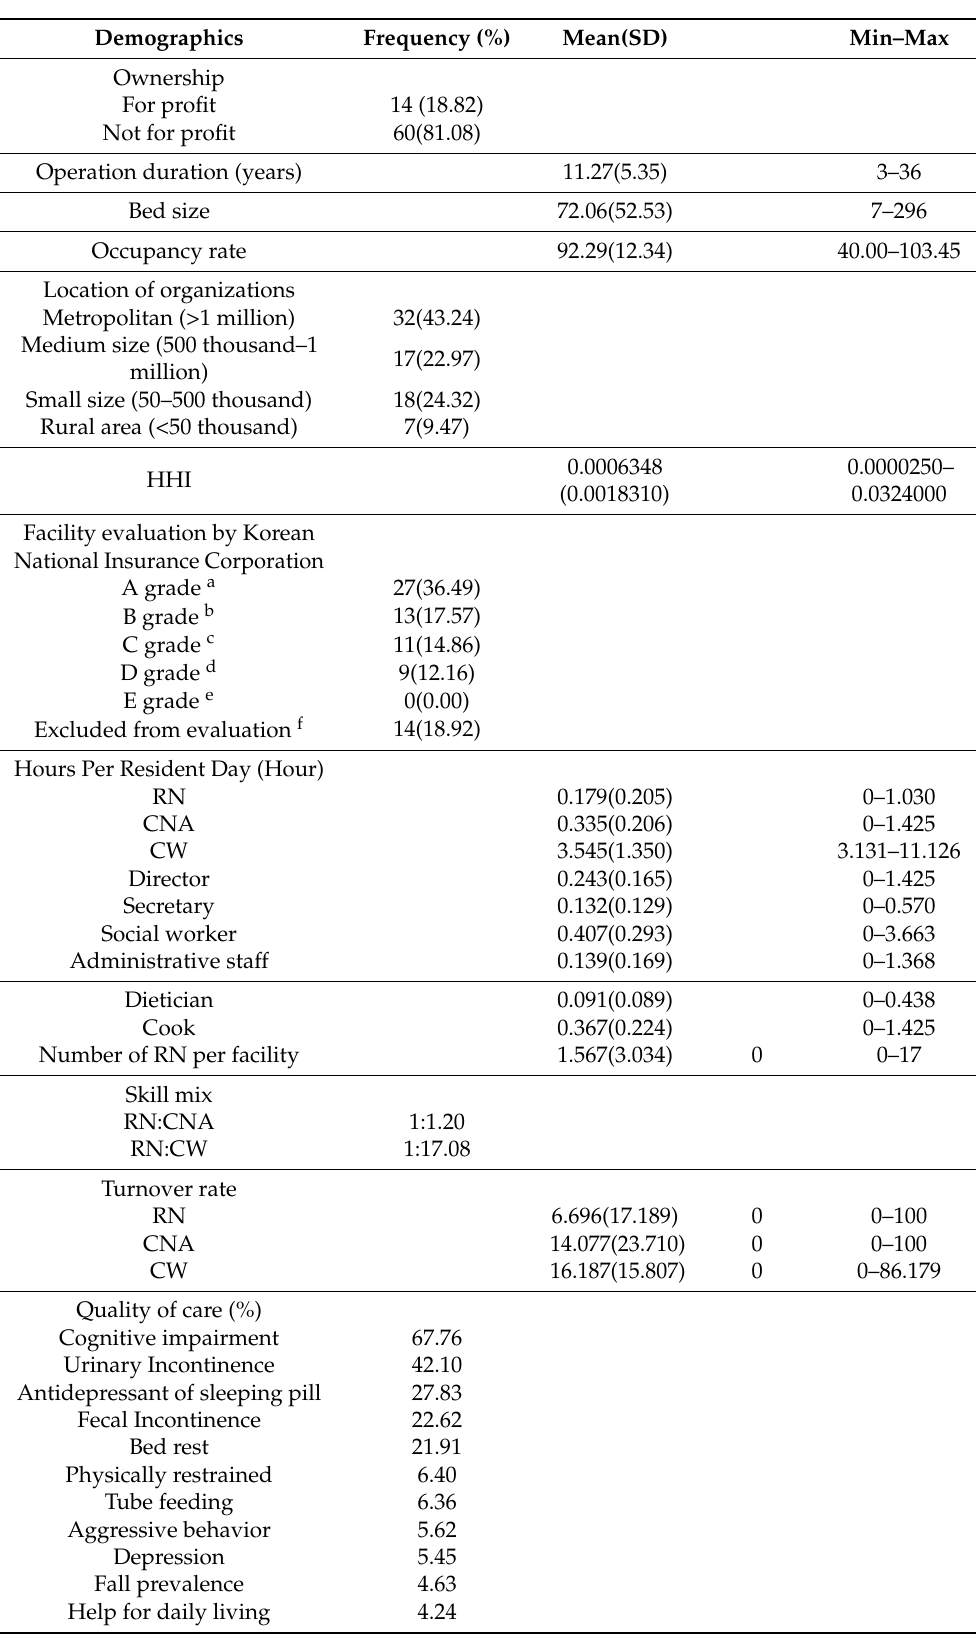
Table 1. Organizational Characteristics of 74